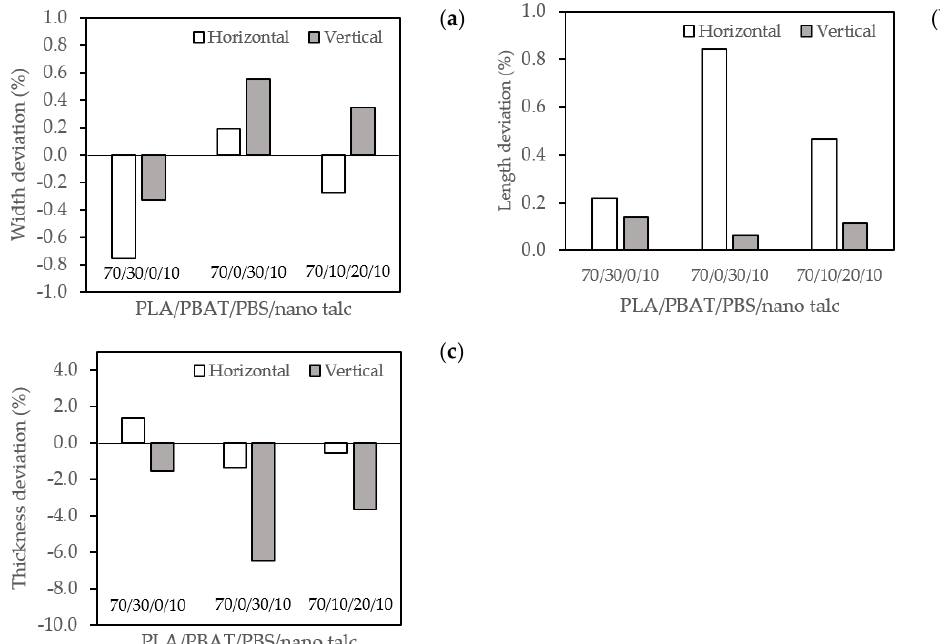
Figure 11. Dimensional deviation of PLA/PBAT/PBS/nano talc composites 3D prints: ( a ) Width deviation; ( b ) Length deviation; ( c ) Thickness deviation.